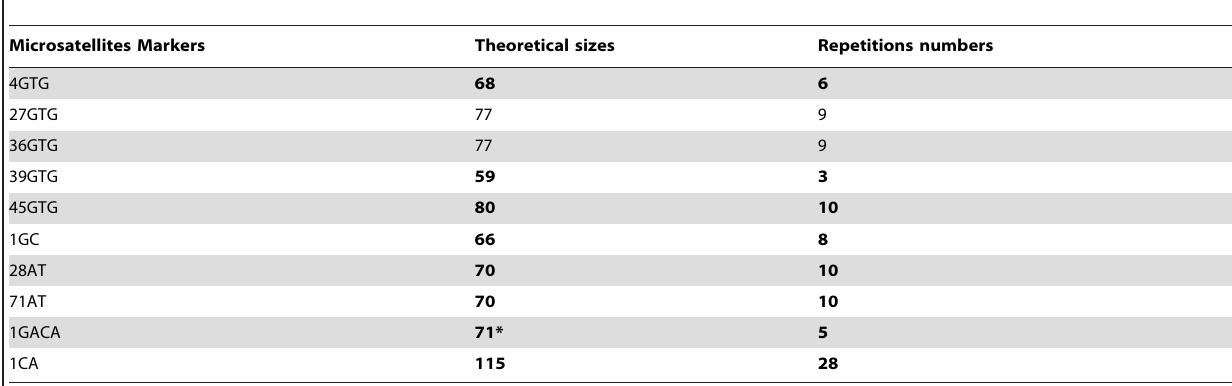
Table 1. Theoretical sizes and repetition numbers among the ten-microsatellite loci in Tunisian studied isolates.